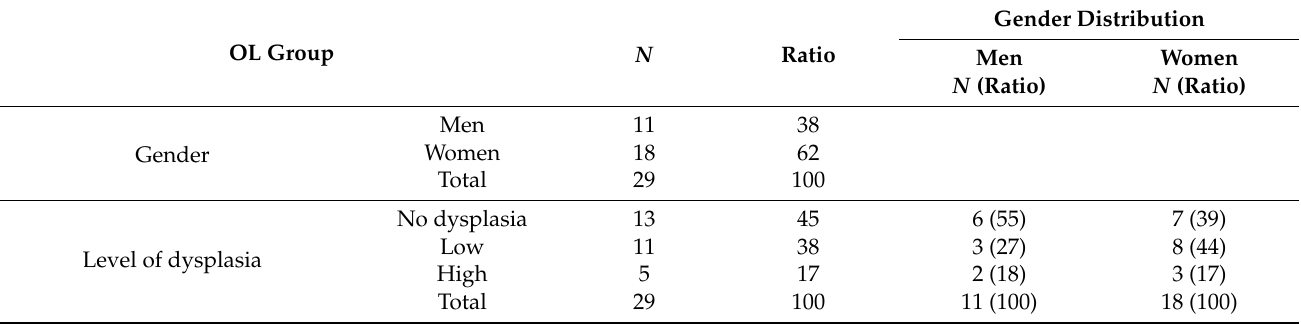
Table 1. Clinical and pathological characteristics of OL and NOM